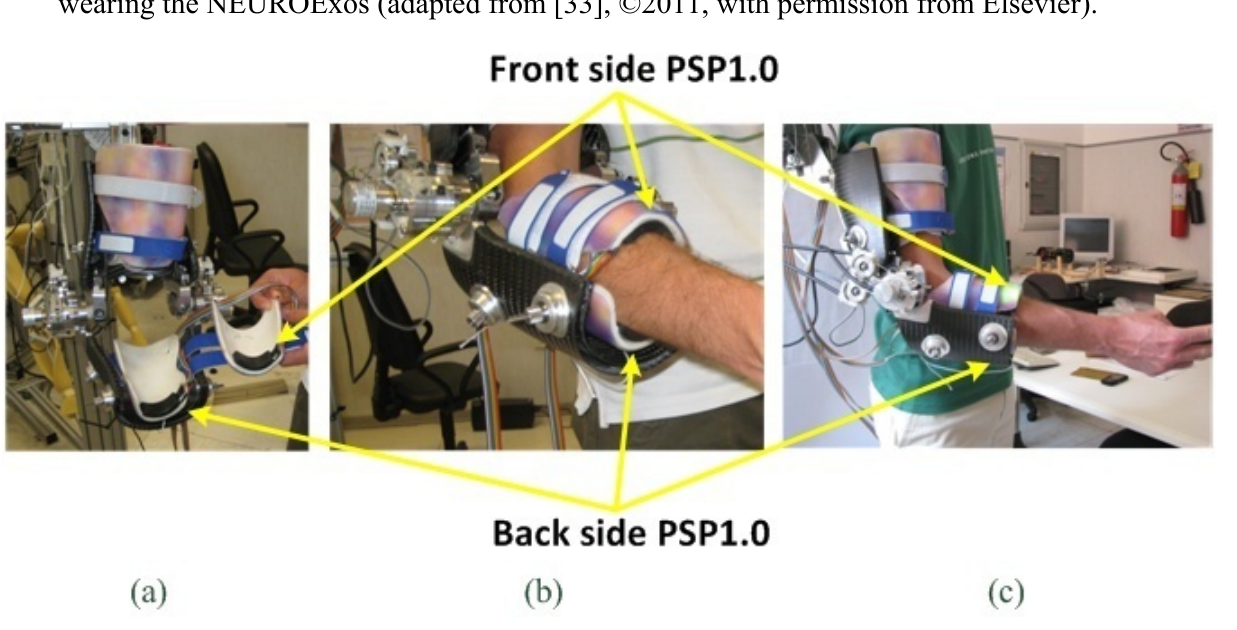
Figure 10. The NEUROExos platform equipped with two PSPs 1.0. ( a ) PSP placement onto inner-side of exoskeleton inner-shells; front ( b ) and lateral ( c ) view of a